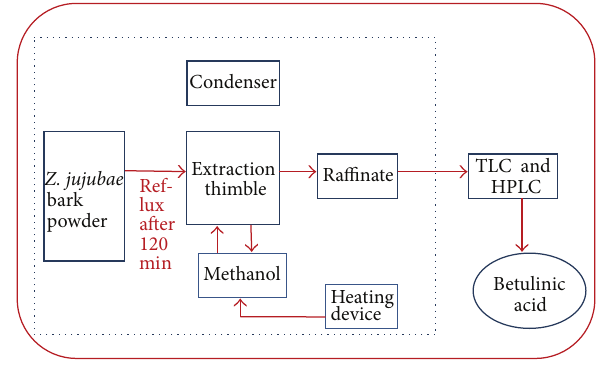
Figure 4: Line diagram for soxhlet extraction method.